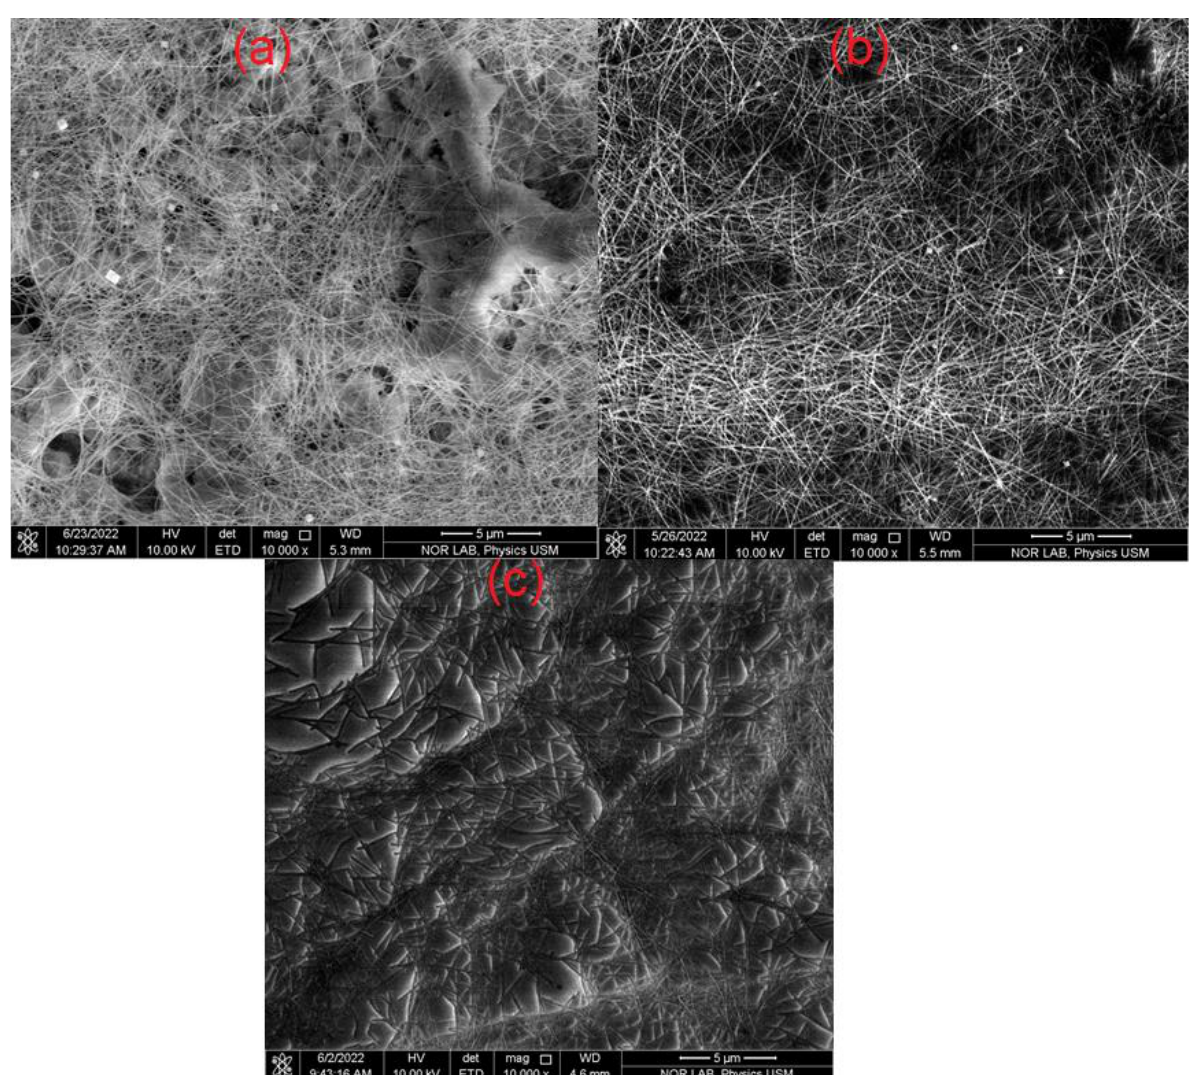
Figure 6. FESEM images of ( a ) AgNWs/cement; ( b ) AgNWs/wood; and ( c ) AgNWs/glass.